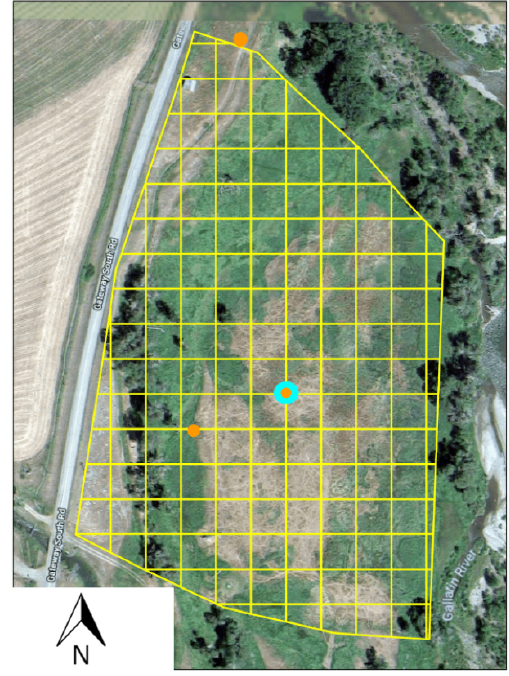
Figure 1. The study site near Gallatin Gateway, MT (45.557 ◦ , − 111.229 ◦ ). Bison locations are mapped within the 20m grid here superimposed in yellow. The tower location is in cyan, and game camera locations are indicated in orange. Background im- age: © Google, Maxar Technologies and the USDA Farm Service Agency 2018.